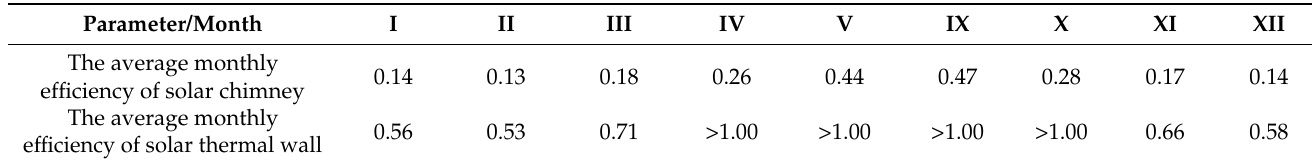
Table 9. The estimation of the average monthly efficiency of the SAH in the form of a solar chimney and thermal storage